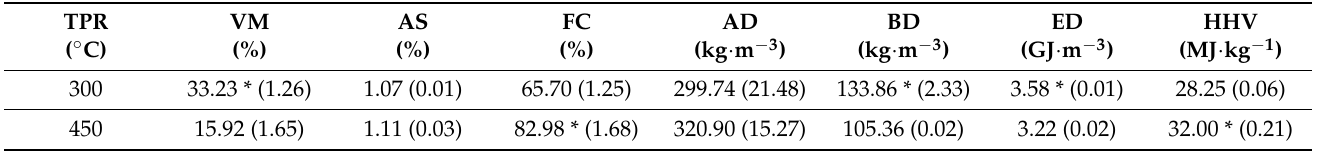
Table 1. Results obtained from the charcoal characterization.